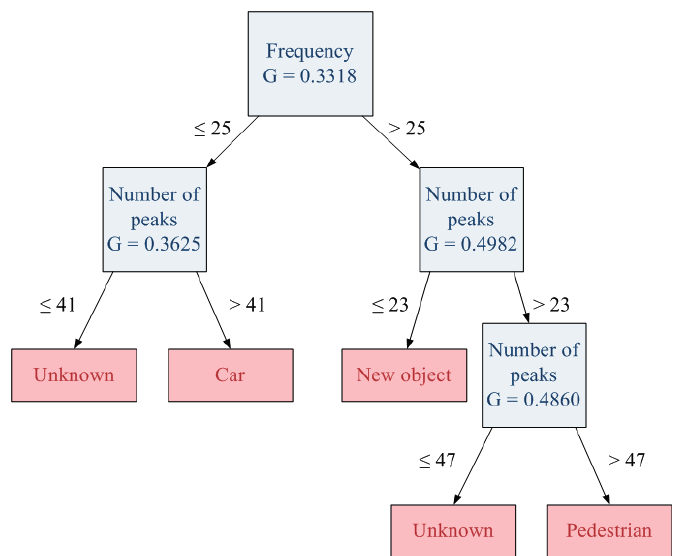
Figure 19. Decision tree with less pruning threshold (0.05).